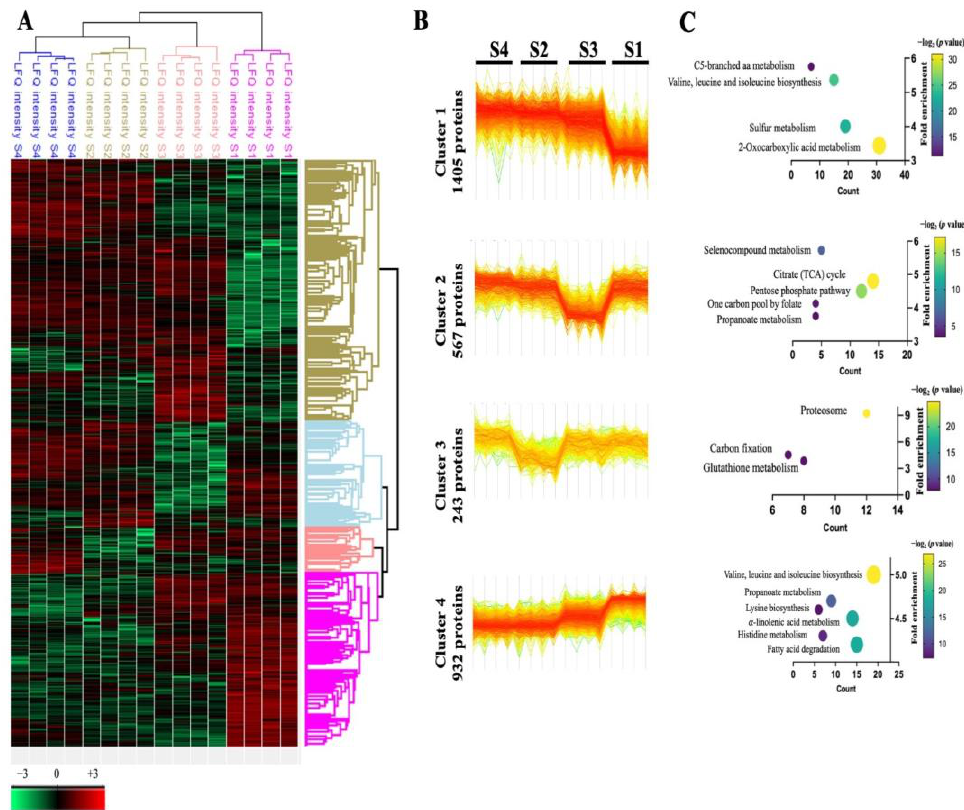
Figure 3. Hierarchical heatmap cluster of diferential persulfidated proteins. ( A ) Heatmap of proteomic analysis from carbon-starved (S1, S3) and non-starved grown plants (S2, S4). Proteins detected in all samples were submitted to ANOVA testing (FDR 0.05) and hierarchical clustering using Perseus. Top column shows dendrogram clustering based on the biological replicates of the four sample sets and row dendrogram clustering data based on differential proteins. Values are displayed as Z-score. ( B ) Protein profiles of the proteins within each cluster. ( C ) KEGG pathway annotation from DAVID database. Graphics show the name of the pathway, dots represent the number of identified proteins (count, x axis) and the fold of enrichment (y axis), and the color code represents the –log 2 p value.